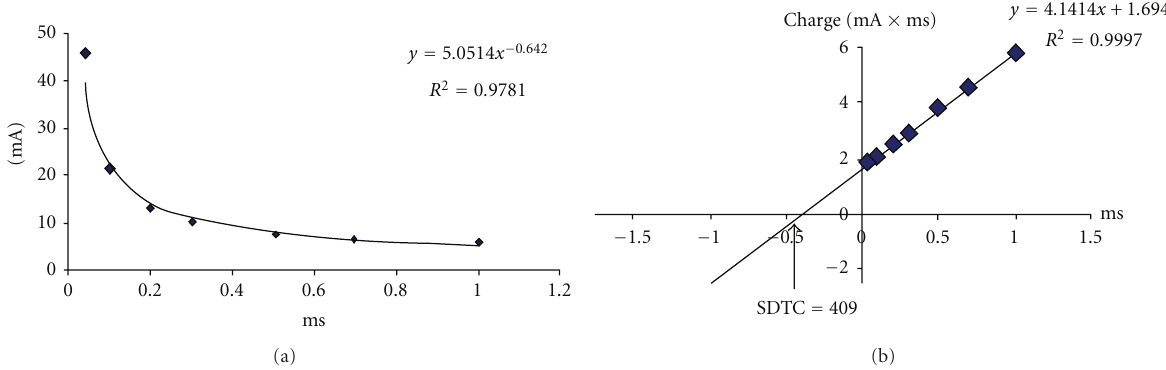
Figure 1: (a) The relationship between stimulus strength (mA) and stimulus duration (ms) in patient 11. (b) The relationship between stimulus duration and the stimulus charge in the same patient. The SDTC is given by the intercept of the linear regression line on the duration axis and was calculated as follows: when y is accepted as zero, x is obtained by dividing 4.1414 by 1.6941, as an